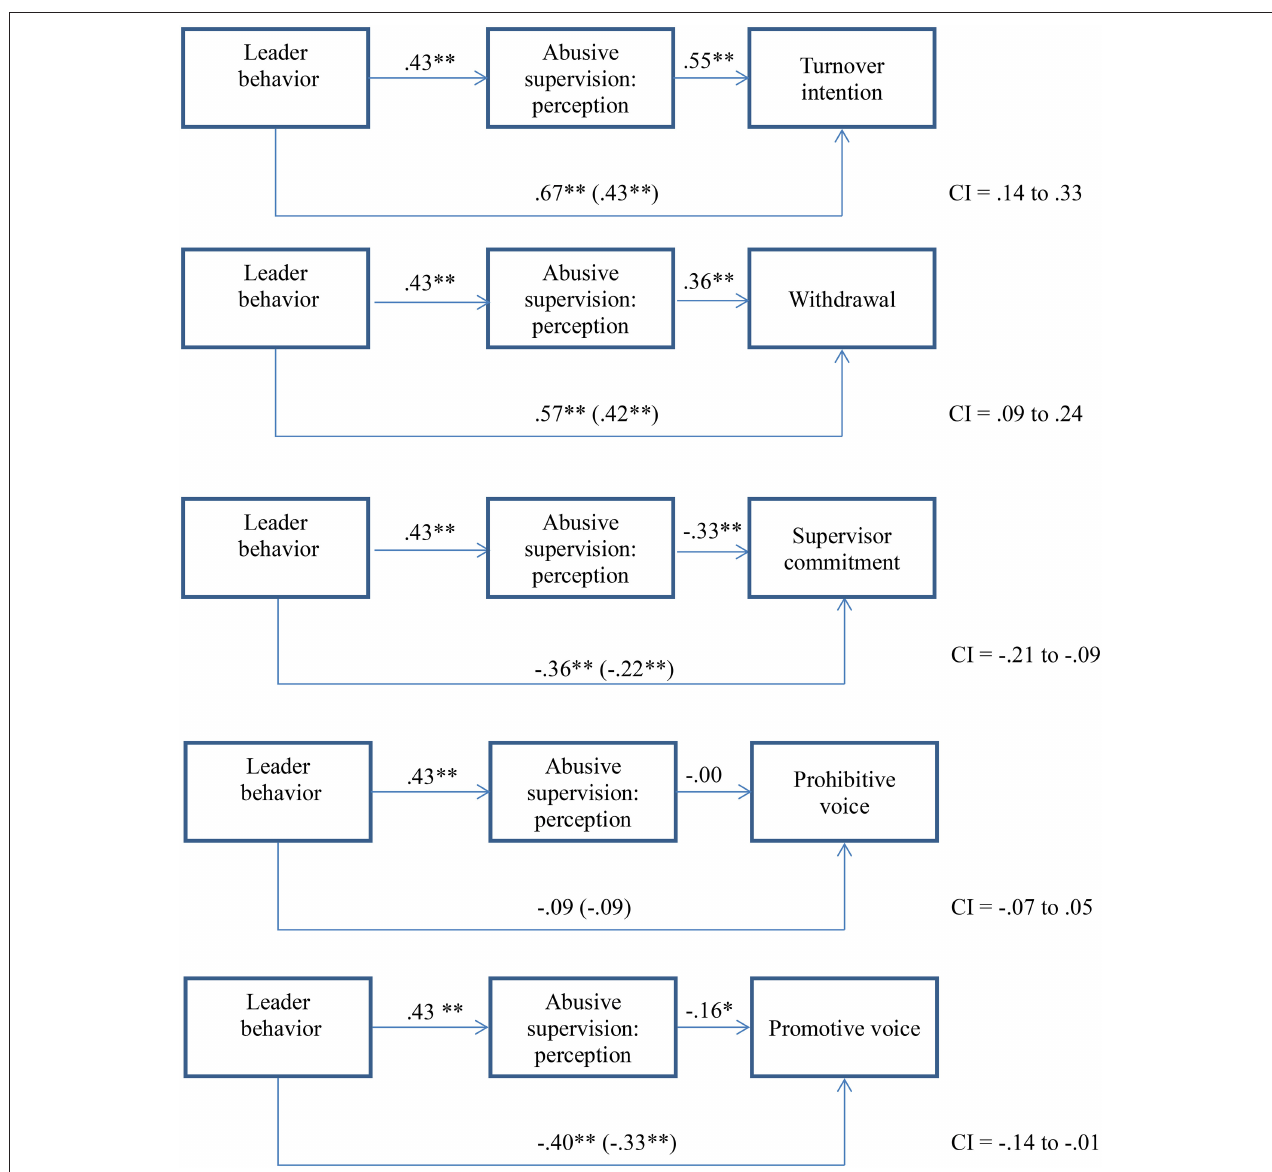
FIGURE 3 | Mediation of perception on the relationship between behavior and reactions (including negative affectivity as control; Study 2). * p < 0.05 (2-tailed), ** p < 0.01